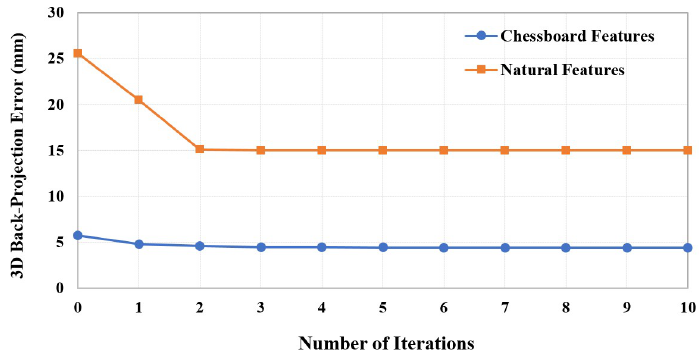
Figure 7. 3D back-projection error after optimization related to number of